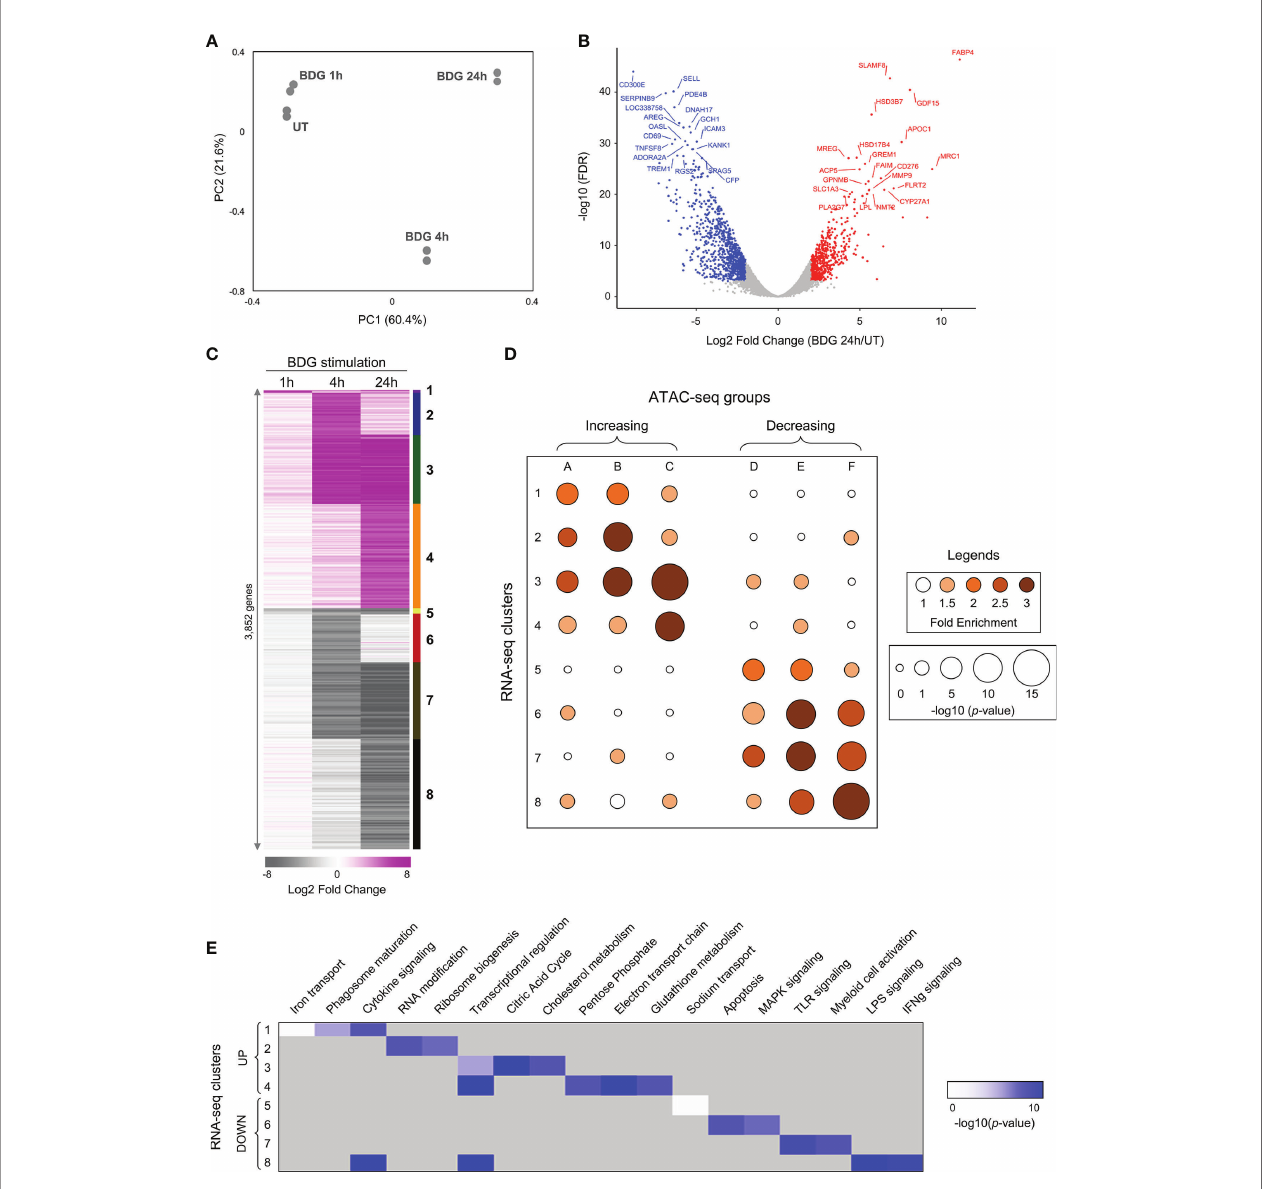
FIGURE 2 | Differential gene expression of monocytes after exposure to BDG. (A) Principal component analysis of RNA-seq data from untreated monocytes (UT) or monocytes exposed to BDG for 1h, 4h, and 24h. (B) Volcano plot of differentially expressed genes after 24h of BDG exposure compared to resting monocytes. False discovery rates (FDR) are calculated using Fisher ’ s exact test with correction using the Benjamini and Hochberg method. (C) Heatmap identifying groups of genes that are differentially expressed after 1, 4, and 24 hours of BDG exposure. Genes are grouped (1 – 8) based on a cutoff of fold-change > 2 (upregulated) or < 0.5 (downregulated) and FDR < 0.001. (D) Bubble histogram showing the association between groups of differentially accessible regions and clusters of differentially expressed genes after BDG exposure. The color gradient re fl ects the ratio in the number of regions in each cluster associated with differentially expressed gene groups compared to control sets of randomly selected genes. Bubble size indicates the strength of the – log10 Fisher ’ s exact test p-value for the association between DARs and differentially expressed genes compared to randomly selected control genes. (E) GO category enrichment analysis for groups of differentially expressed genes (white to blue gradient represents degree of enrichment, grey – not